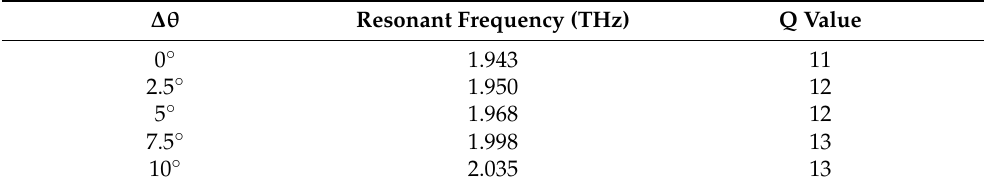
Figure 2. Transmission spectra of the metamaterial sensor with different changing angles ( a ) and with different rotation angles ( b ). Table 1. Resonant frequency and Q value of the metamaterial sensor with different changing angles.